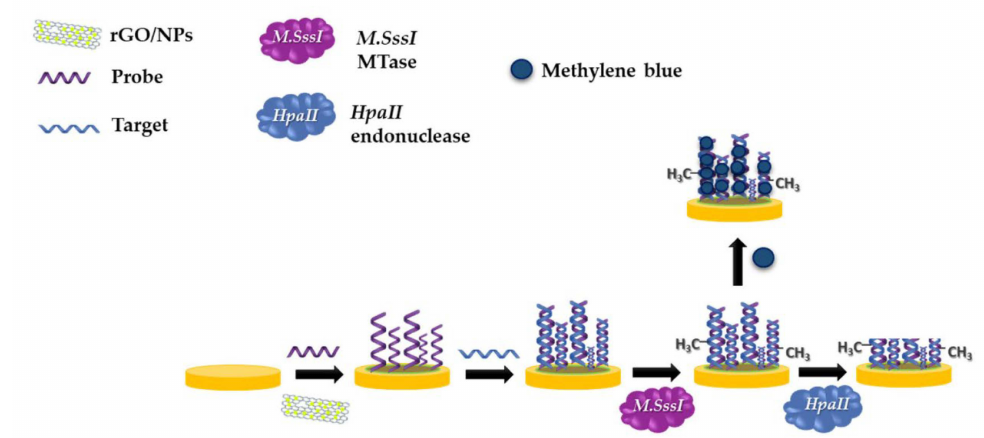
Figure 12. Schematic illustration of DNA biosensor construction and detection process. Reprinted with permission from Ref. [103]. Copyright 2020, this article is licensed under a Creative Commons Attribution 4.0 International